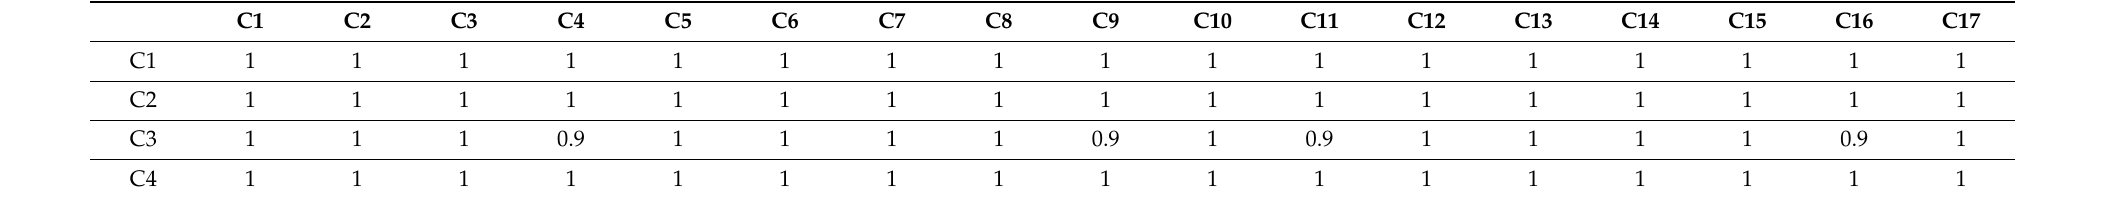
Table A4. Cause–cause matrix to conversion